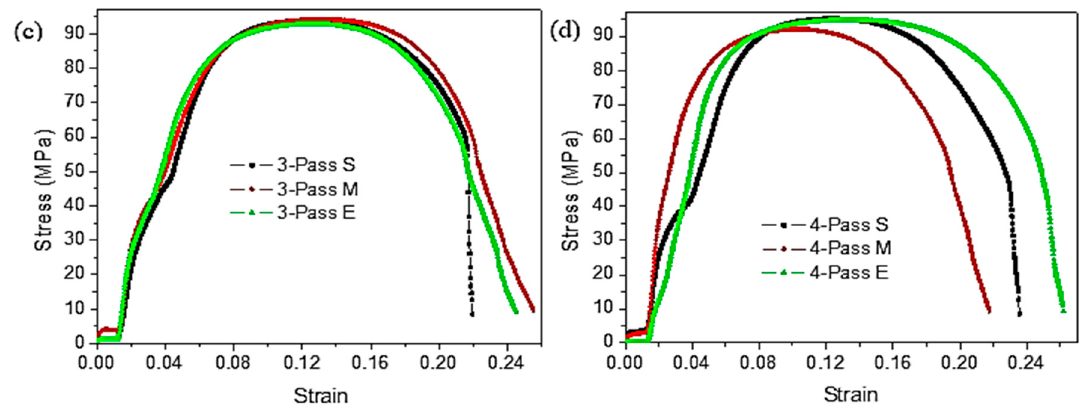
Figure 5. Multiple pass SFSP stress–strain curves, ( a ) 1-pass, ( b ) 2-pass, ( c ) 3-pass and ( d ) 4-pass.